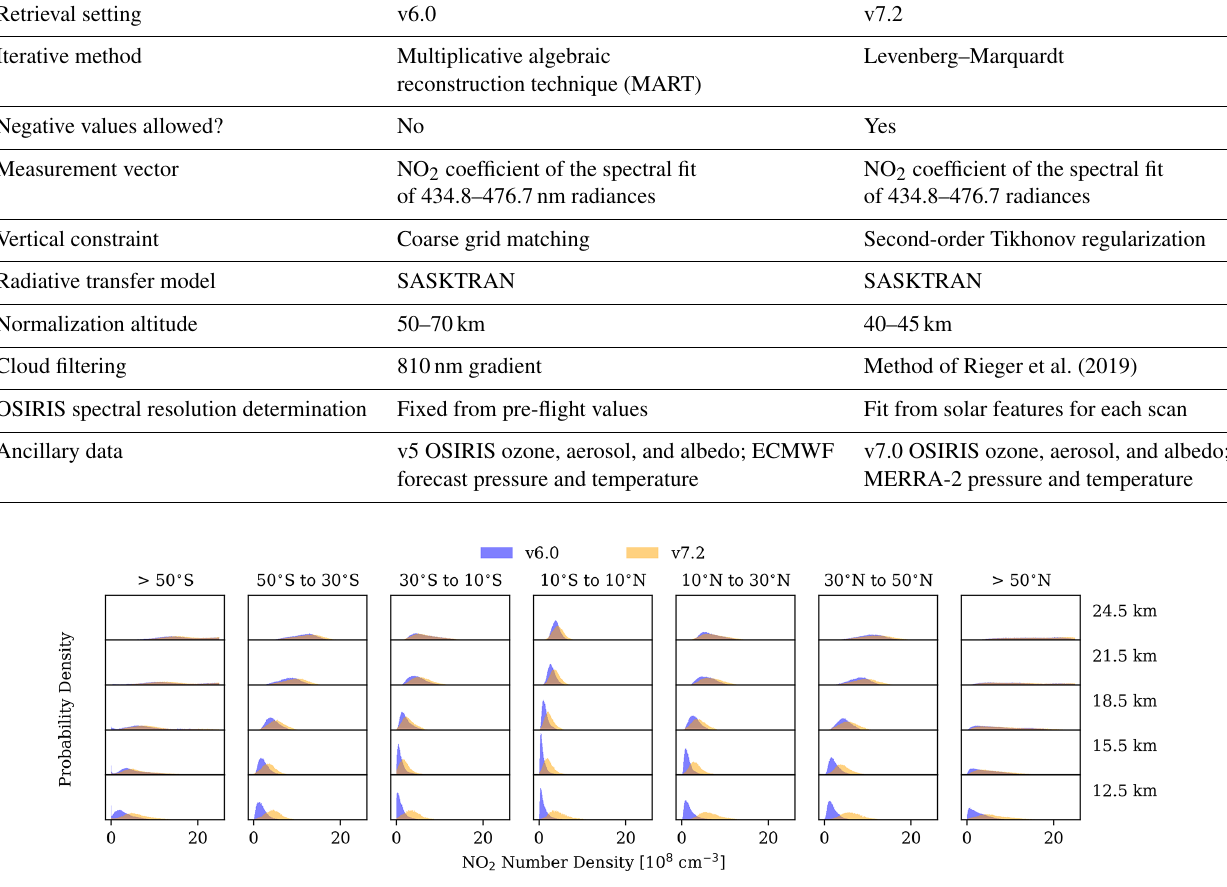
Figure 3. Probability densities for v6.0 and v7.2 OSIRIS NO 2 at several